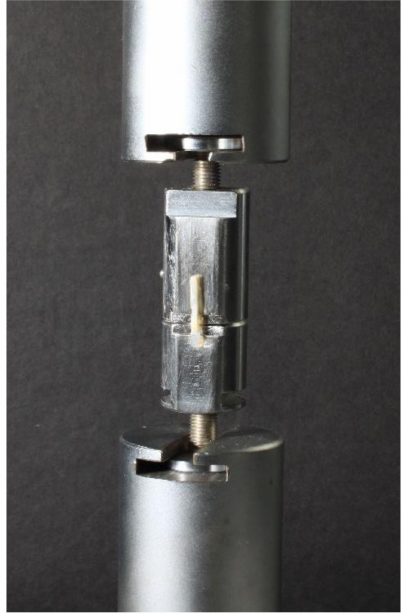
Figure 3. After obtaining 1 mm × 1 mm beam-shaped sticks by longitudinally sectioning teeth using Isomet saw, each stick was glued with cyanoacrylate adhesive to specifically designed metal plates and placed in universal testing machine Afterward, tensile load was applied to each beam at a crosshead speed of 0.5 mm/min until it fractured.